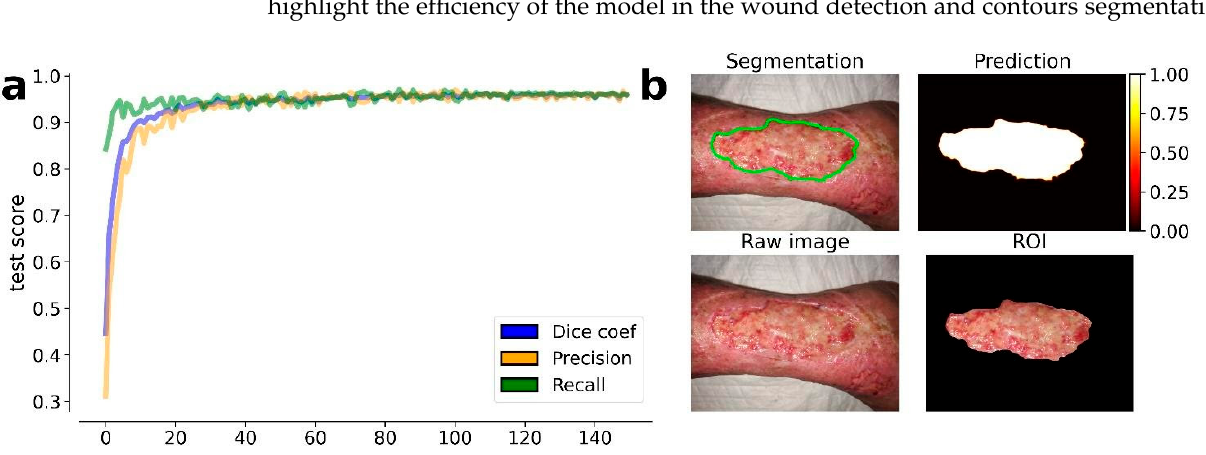
4 of 11 Table 1. Results obtained by the U-Net model using the active semi-supervised learning procedure at each round. We report the number of images used for the training, the number of images used for the validation, the number of correctly segmented validation images (according to the expert evaluation), and the metric scores achieved (on the test set) after 150 epochs for each round of train- ing, respectively. The percentages of training and validation images are referred to the whole set of available samples, i.e., 1564 images. The percentage of correct segmentation is referred to the total number of validated images per each round. Round 0 Round 1 Round 2 Round 3 N° training images